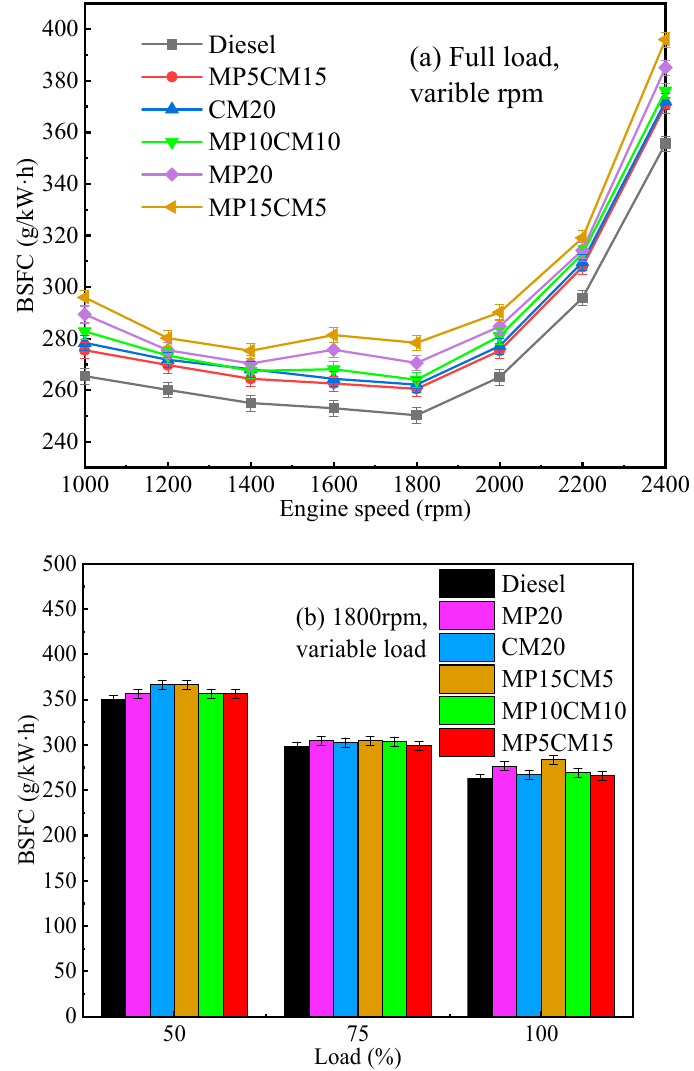
Figure 17. BSFC at different engine conditions. ( a ) Different speeds; ( b ) Different loads [193].